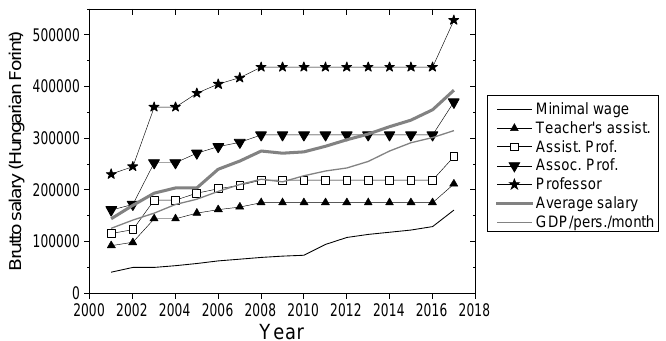
Figure 2. Salaries in academia compared to the minimal wage, the average salary for white collar jobs and the per capita GDP. Data reflect the minimal wage and salaries at the start (1st of January) of the respective years. Minimal wage since 2011 has been higher for employees having at least secondary education relevant to their jobs, as those data have shown. Data are from [24], the Hungarian Central Statistical Office and from the laws of